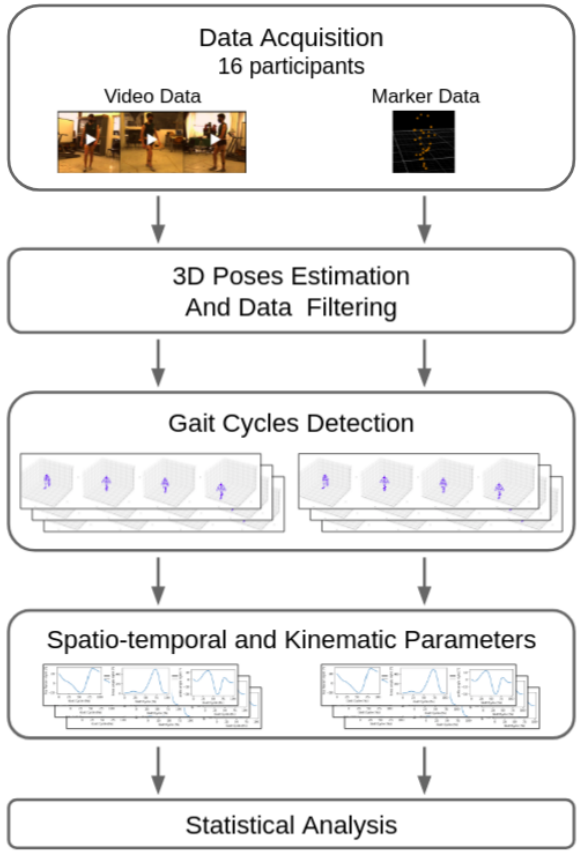
Figure 1. Summary of the